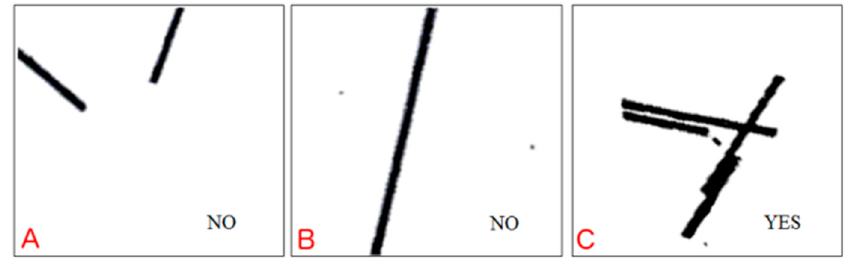
Figure 6. Particle counting: ( A , B ) If the elements are cut by the outline of the microscopic reticle, these will be discarded, and ( C ) if the elements fall within the outline of the microscopic reticle, these will be considered [24].